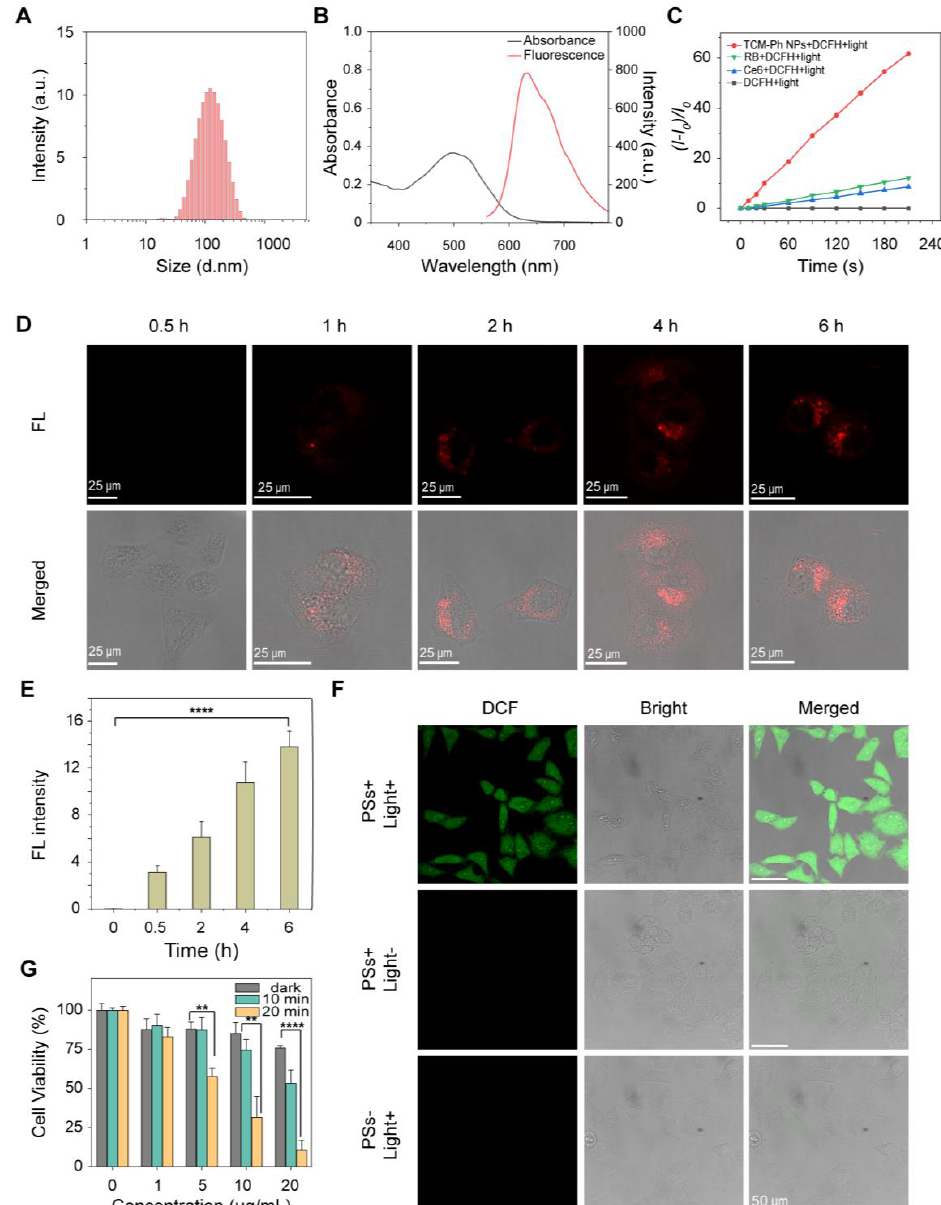
Figure 4. Efficient cell penetrating and tumor cell ablation of TCM-Ph NPs. ( A ) Size distribution of TCM-Ph NPs in water. ( B ) Absorbance and fluorescence spectra of TCM-Ph NPs in water, λ ex = 497 nm. ( C ) Light-induced total ROS generation of Ce6, RB, and TCM-Ph NPs, evaluated by DCFH (40 µ M). The plot of relative PL intensity ( I - I 0 )/ I 0 at 525 nm versus the different irradiation times, where I 0 is the fluorescence value of the mixture at 525 nm before illumination and I is the fluorescence value of the mixture at 525 nm after illumination, respectively, λ ex = 488 nm. ( D ) CLSM of HeLa cells incubated with TCM-Ph NPs (10 µ M based on TCM-Ph) for different times. Red channel from TCM-Ph NPs: λ ex = 514 nm, λ em = 550–700 nm. Scale bar: 25 µ m. ( E ) Average fluorescence intensity of cells incubated with TCM-Ph NPs (10 µ M based on TCM-Ph) for different times from Figure ( D ) (down). Data are shown as mean ± s.d., with n = 3, **** p < 0.0001. ( F ) Intracellular ROS level in HeLa cells under various treatments detected by reaction between DCFH and ROS. Green channel from DCFH: λ ex = 488 nm, λ em = 505–560 nm. Scale bar: 50 µ m. ( G ) In vitro cytotoxicity of different concentrations of TCM-Ph NPs under dark, 10 min and 20 min white-light irradiation. Light: 50 mW cm − 2 , > 400 nm. Data are shown as mean ± s.d., with n = 3, **** p < 0.0001, ** p <